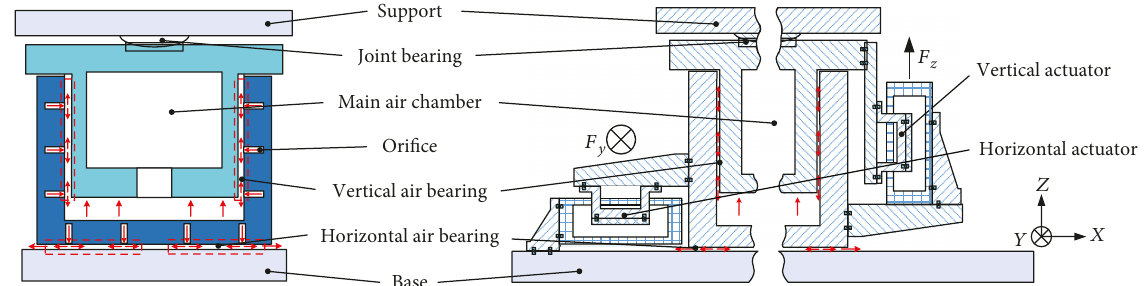
Figure 1: Conceptual design of the isolator.